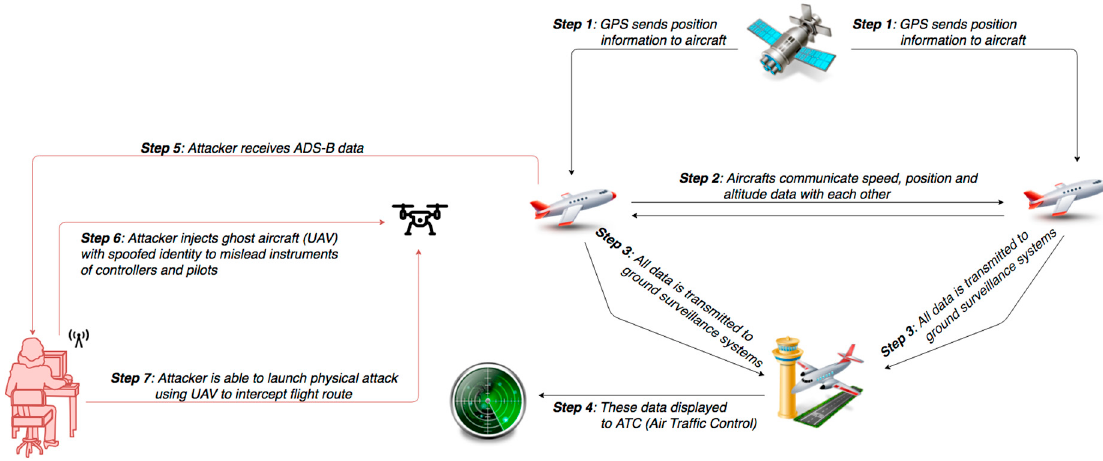
Figure 8. Communication attack on ATM systems.